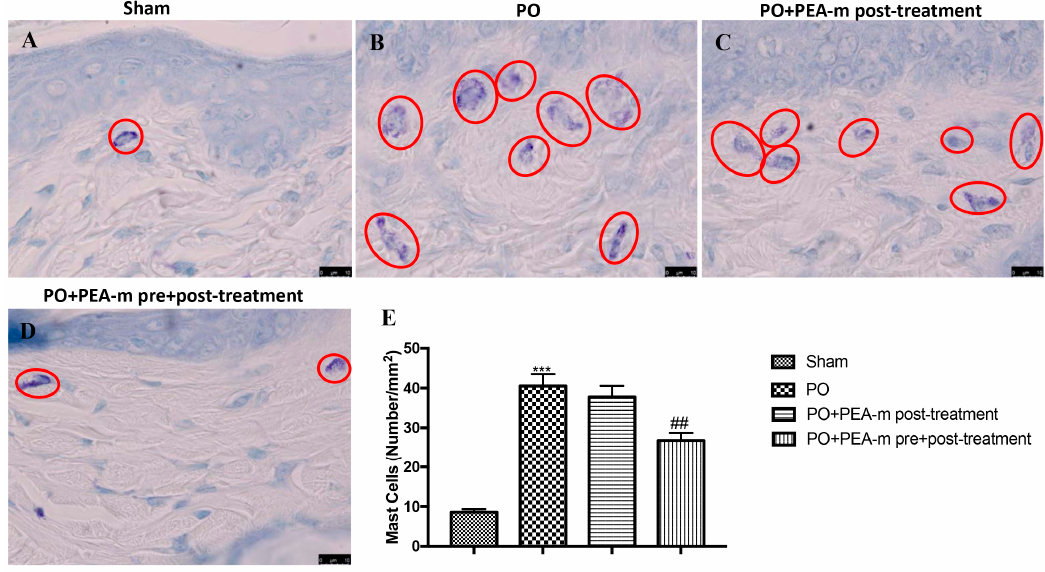
Figure 2. Effects of PEA-m on Mast Cells. Toluidine blue staining was used to identify mast cell infiltration (encircled in red), characterized by dark lilac blue granules: ( A ) sham group; ( B ) PO group; ( C ) PO + PEA-m post-treatment group; ( D ) PO + PEA-m pre + post-treatment group. ( E ) Mast cell number per unit area of tissue (mast cell density). Figures are illustrative of at least three distinct experiments. Values are means ± standard error of the mean (SEM) of five animals for each group. *** p < 0.001 vs. sham, ## p < 0.01 vs. PO.